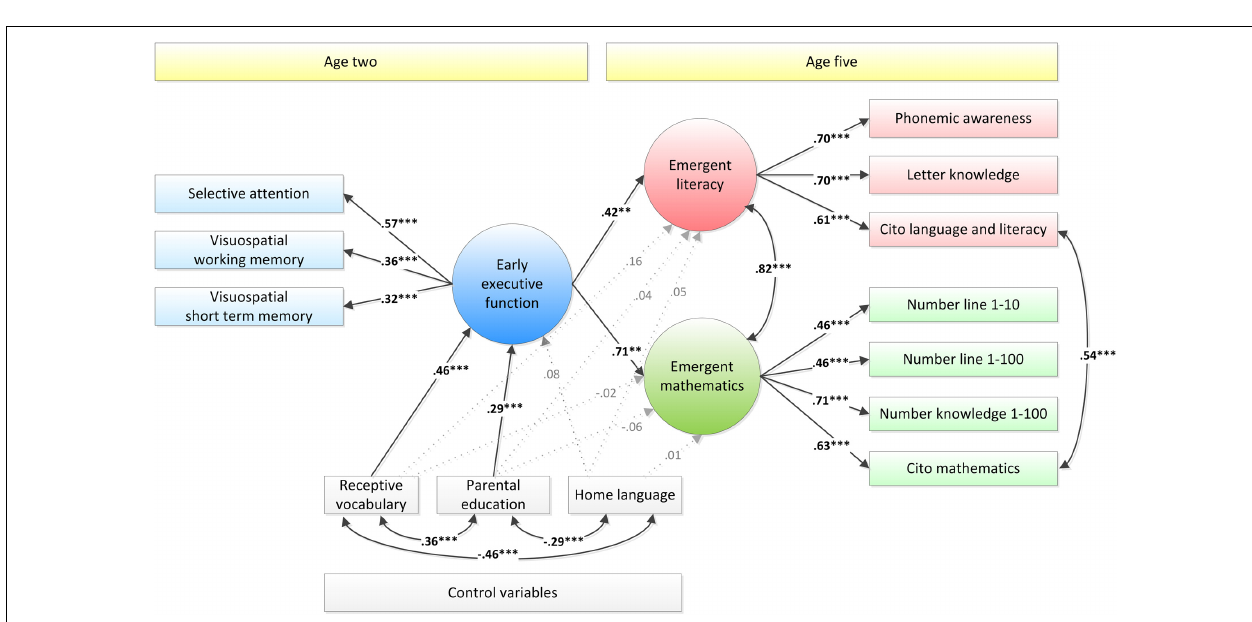
FIGURE 2 | Structural Equation Model with early EF at age two as a predictor of emergent mathematics and literacy at age five, with only non-verbal tasks as indicators of early EF. Standardized estimates are presented. Dotted, gray lines represent non-significant coefficients. ∗ p < 0.05, ∗∗ p < 0.01, ∗∗∗ p < 0.001.